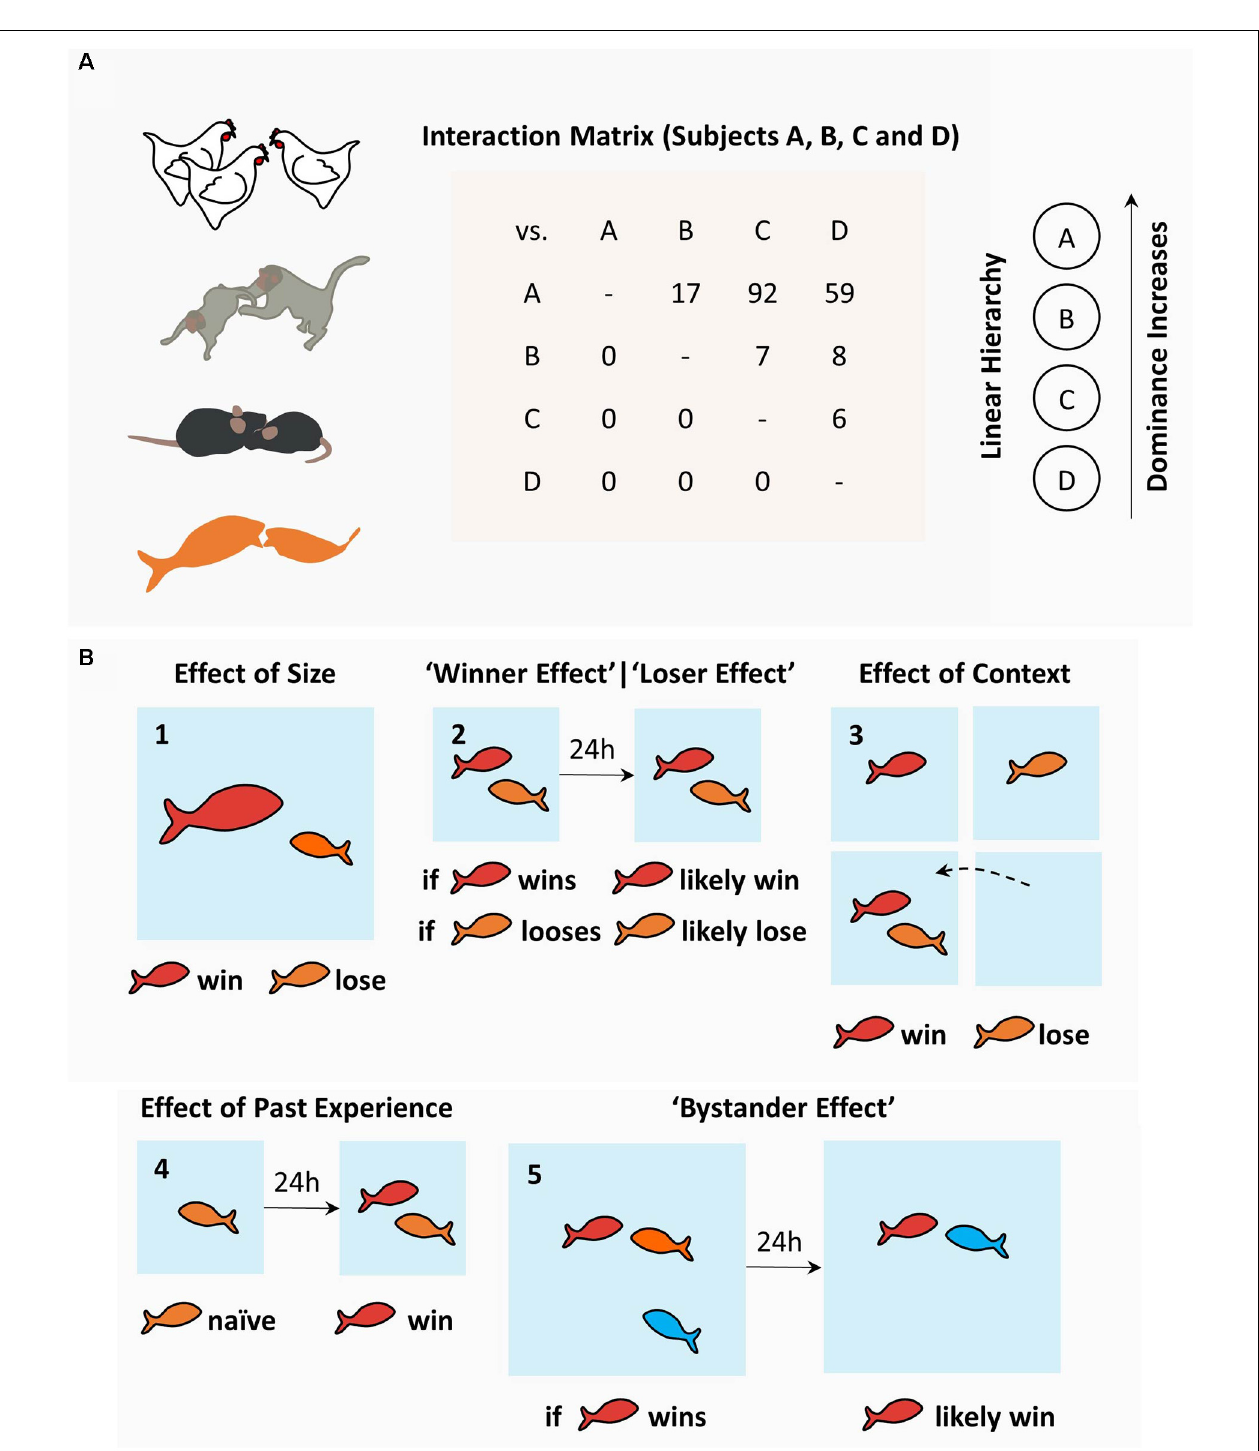
FIGURE 1 | The sociobiology of hierarchies: determinants and consequences. (A) Social hierarchies, or pecking orders, emerge in diverse animal species and can be characterized using interaction matrices as used by Schjelderup-Ebbe, depicting the number of attacks (or victories) of one individual over others, which may lead to social hierarchies in a variety of topographies (linear hierarchy displayed from the matrix data). (B) Determinants of social hierarchies in fish models include: (1) effect of size; (2) effect of past winning (“winner effect”) and past losing (“loser effect”); (3) the effect of familiar vs. novel context (“homefield”); (4) effect of past experience; and (5) the bystander effect. Among fish, dominance is attained by bigger fish and winning experience when fighting familiar opponents in a familiar context. Rodents share most of these rules. More complex species, such as primates, have additional, more complex determinants (see text).